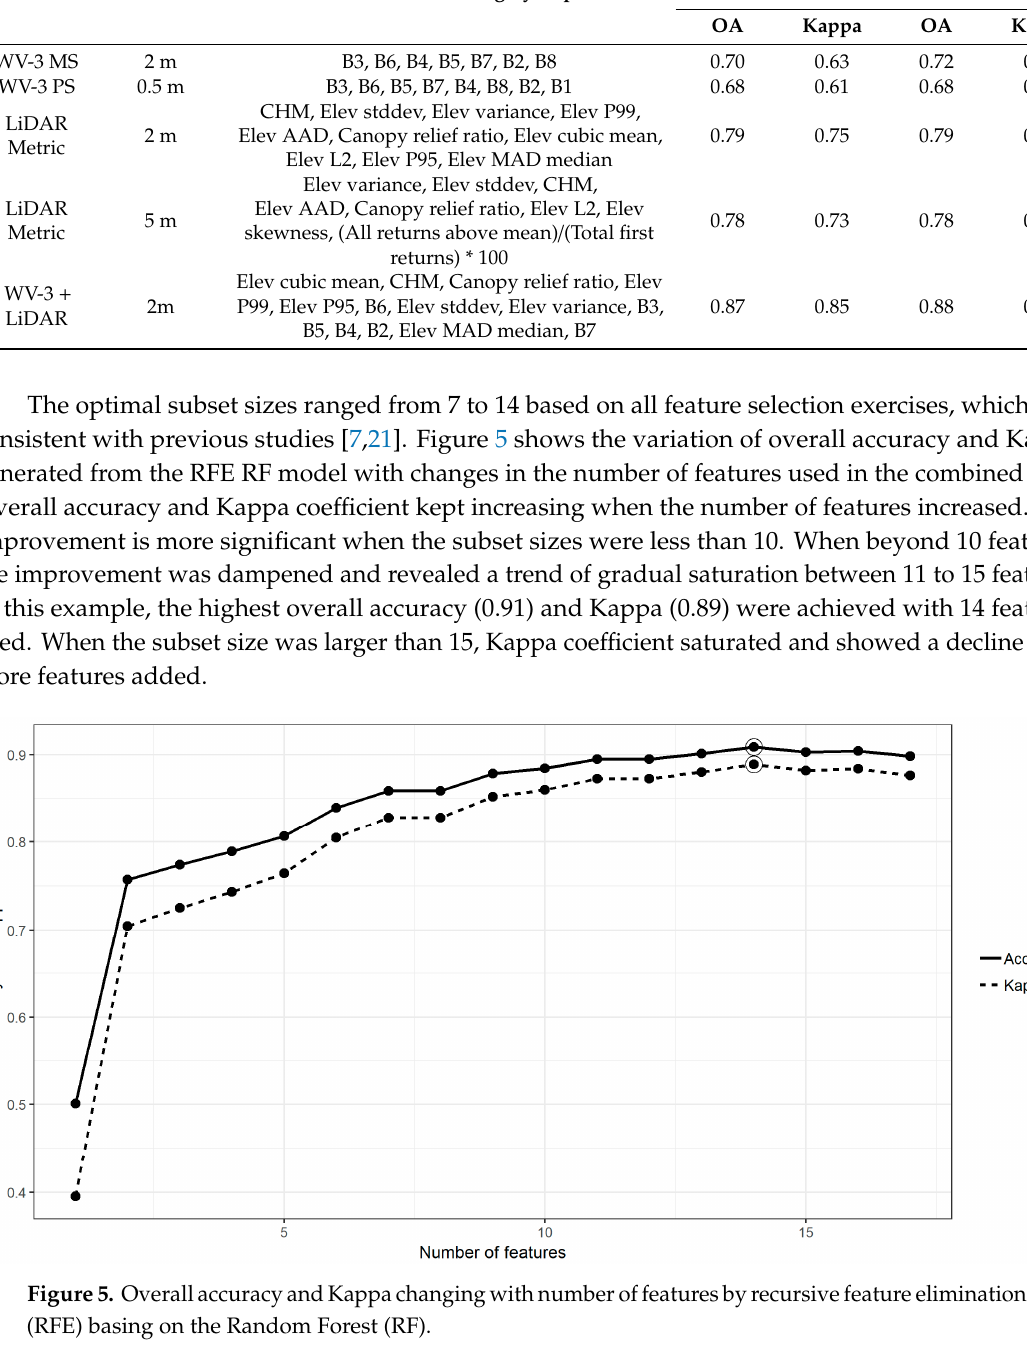
Table 4. Confusion matrix for classification with WV-3 data.